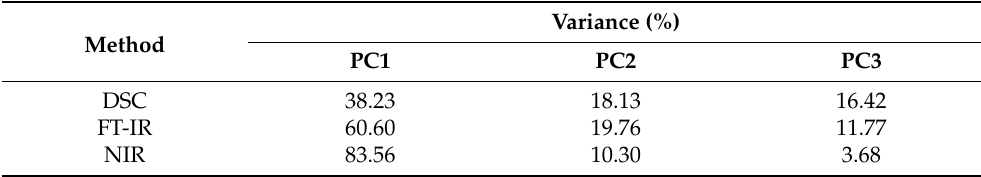
Table 4. Values of the first three principal components (PC1, PC2 and PC3) calculated for thermal and spectral data sets.